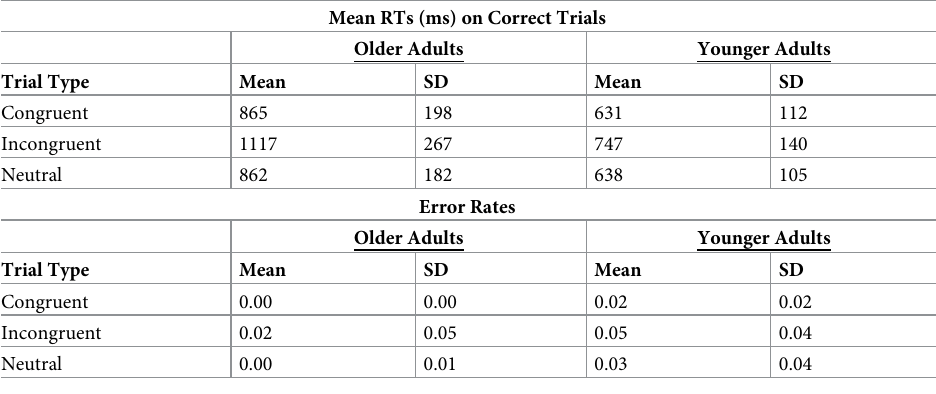
Table 1. Baseline descriptive statistics for response latency and